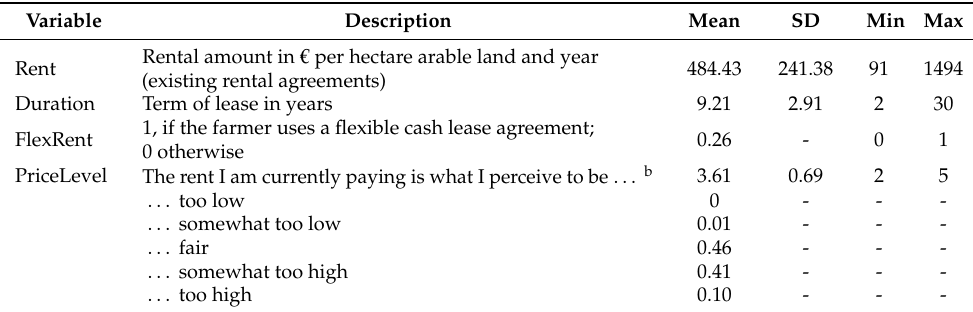
Table 4. Descriptive statistics on farmers’ lease agreements (N = 155) a .